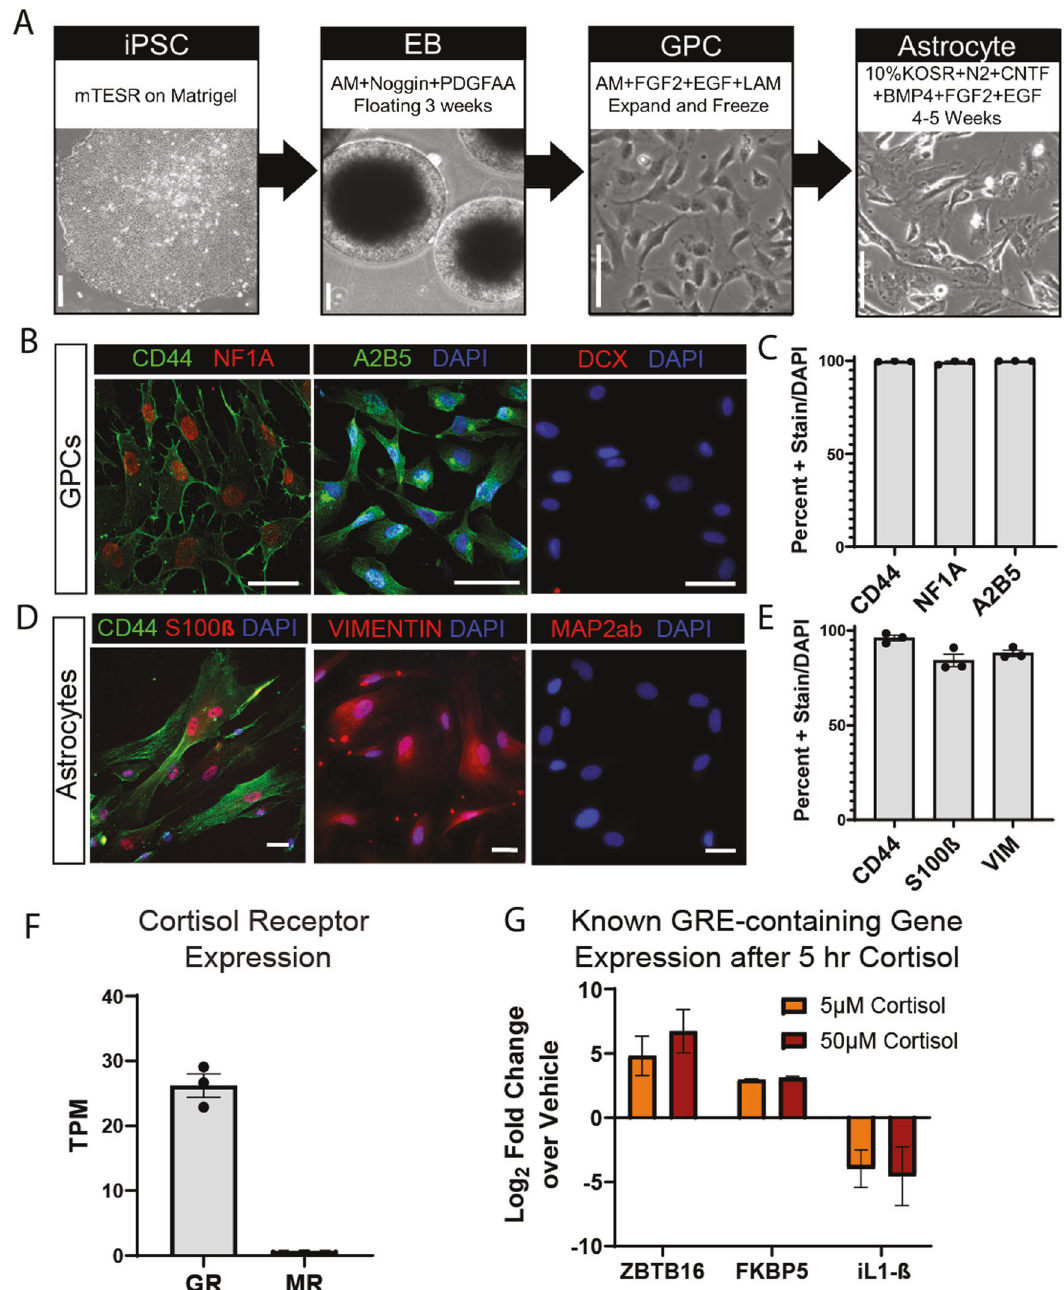
Fig. 1 iPSC-derived astrocytes differentiated in serum-free conditions express appropriate glial markers and respond to cortisol in vitro. a Schematic of serum-free astrocyte differentiation from iPSCs via fl oating embryoid body (EB) and glial progenitor cell (GPC) intermediate stages. Representative bright fi eld images depict major steps. Scale bars 100 µm. b Representative fl uorescent images of immunostained GPCs expressing early glial fate markers CD44 (left-green), NF1A (left-red), and A2B5 (middle-green) and negative stain for early neuronal marker DCX (right-red); scale bars 50 µm. c Quanti fi cation of immunostain showing percent of GPCs expressing CD44, NF1A, and A2B5 out of DAPI identi fi ed total cells. Bars depict mean ± SEM; n = 3 individuals. d Representative fl uorescent images of immunostained astrocytes expressing CD44 (left-green), S100 β (left-red), and Vimentin (middle-red) and negative stain for neuronal marker Map2ab (red-right); scale bars 50 µm. e Quanti fi cation of immunostain showing percent of astrocytes expressing CD44, S100 β , and Vimentin out of DAPI identi fi ed total cells. Bars depict mean ± SEM; n = 3 individuals. f Expression of cortisol receptors Glucocorticoid Receptor (GR) and Mineralocorticoid Receptor (MR) measured via whole transcriptome sequencing under baseline conditions. Bars show mean TPM ± SEM; n = 3 individuals. g Expression of known Glucocorticoid Response Element (GRE)-containing genes, ZBTB16, FKBP5, and L-1 β , following 5 h of Cortisol or Vehicle treatment at 5 µM or 50 µM concentration. RT-qPCR values expressed as log 2 fold change over own vehicle control; bars depict mean ± SEM; n = 6 with 3 replicates in 2